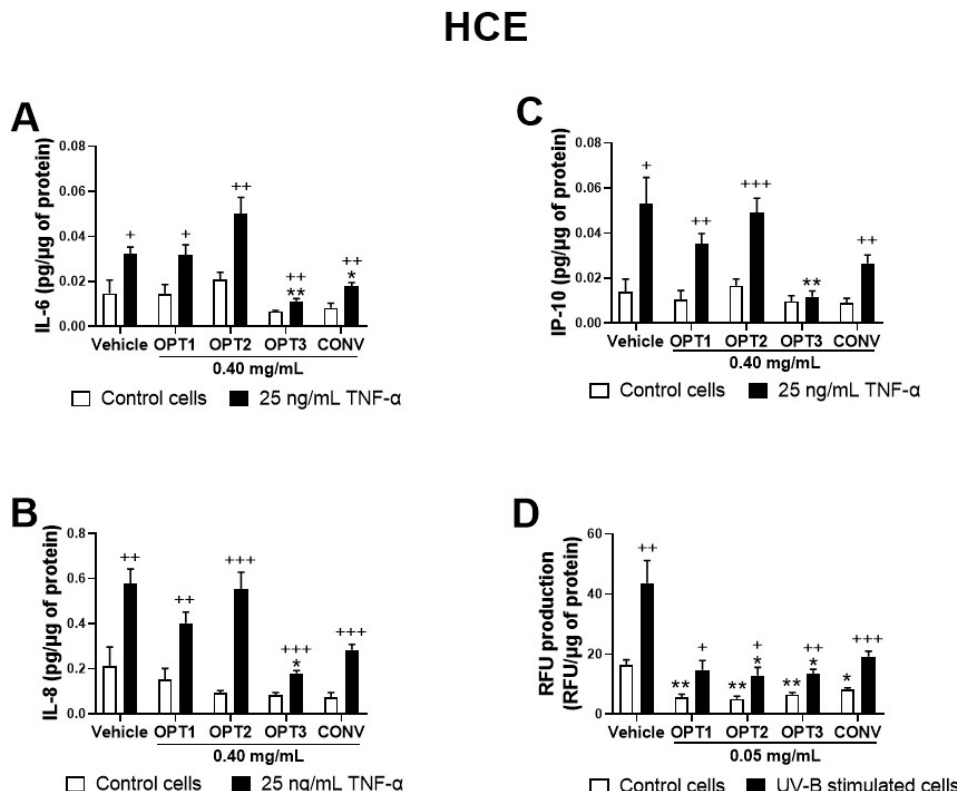
Figure 2. Screening of the anti-inflammatory and antioxidant activity of the conventional (CONV) and the three optimized (OPT1, OPT2, and OPT3) Olive Pomace (OP) extracts on TNF- α -induced cytokine release and UV-B-induced reactive oxygen species (ROS) production by HCE cells, respectively. For cell cytokine stimulation, cells were pre-treated with vehicle (0.4% ethanol) or 0.40 mg/mL of CONV, OPT1, OPT2, and OPT3 for 2 h. Following this, they were stimulated with 25 ng/mL TNF- α in the presence of the treatments for 24 h ( A – C , black bars). Vehicle-treated-TNF- α stimulated cells and cells not stimulated with TNF- α ( A – C , white bars) were used as control. IL-6, IL-8, and IP-10 were measured in cell supernatants by a multiplex bead-based array. OPT3 inhibited all measured cytokines/chemokines ( A – C ), while CONV significantly decreased IL-6 ( A ). For the UV- B-induced ROS production, cells were pre-treated with vehicle (0.4% ethanol) or 0.05 mg/mL of CONV, OPT1, OPT2 and OPT3 for 1 h. Subsequently, cells were incubated with 10 µ M H2DCF-DA solution for 30 min, and then treated with the treatments and exposed to 107.25 mJ/cm2 UV-B light ( D , black bars). After 1 h of incubation, intracellular fluorescence intensity was measured. Vehicle-treated-UV-B stimulated cells and cells not stimulated with UV-B ( D , white bars) were used as control. OPT2 and OPT3 decreased ROS levels significantly. Data are presented as picograms (pg) of cytokine/chemokine (for cell cytokine stimulation) or relative fluorescence units (RFUs) (for ROS production) normalized to micrograms ( µ g) of total protein for three independent experiments (performed in duplicate) ± SEM. * p < 0.05, ** p < 0.01, compared with vehicle-treated cells; + p < 0.05, ++ p < 0.01, +++ p < 0.001, compared with control cells. Vehicle: 0.4% EtOH.